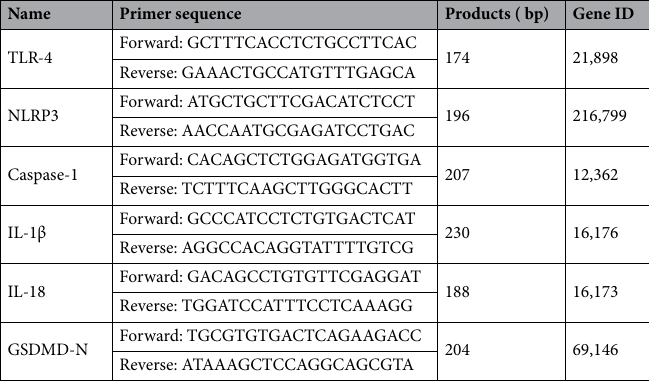
Table 1. Oligonuceotide sequences for Mus musculus gene